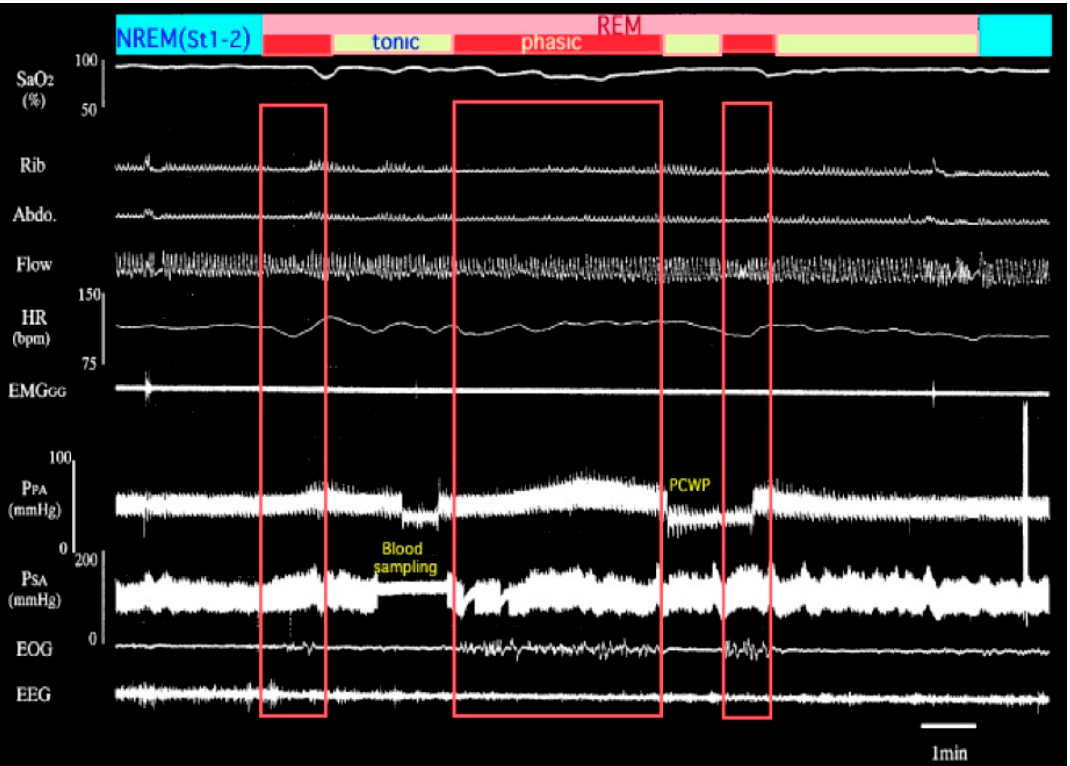
Figure 2. Polysomnographic recording in the same patient who was treated with nasal continuous positive airway pressure (CPAP). Tremendous desaturation before CPAP treatment was restored. However, the increase in pulmonary artery pressure can be observed in association with the appearance of phasic REM, suggesting the participation of neural control. REM-specific elevation in PAP occurred independently of the degree of hypoxia. PCWP; pulmonary capillary wedge pressure. SpO 2 ; arterial oxygen saturation by pulse oximeter, Rib; rib cage movement, Abdo; abdominal movement, Flow; nasal airflow, HR; heart rate, EMG GG ; genioglossal electromyogram, P SA ; systemic artery pressure, EOG; electrooculogram, EEG; electroencephalogram. Phasic; phasic REM, tonic; tonic REM.